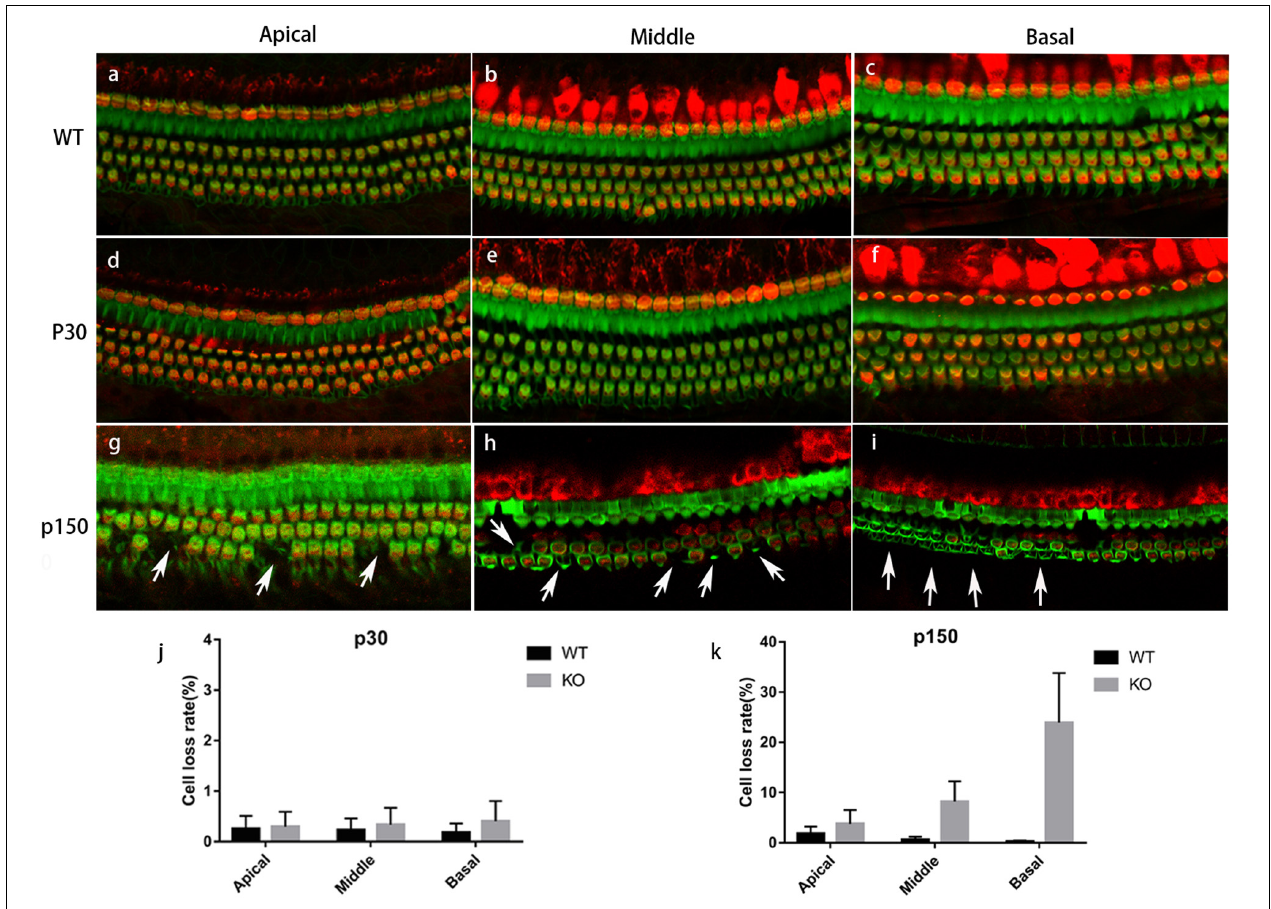
FIGURE 3 | Immunostaining of cochlea basilar membrane. Red: Myo7a, marking the cell bodies; Green: phalloidin, marking the stereocilia. (a-c) Basilar membranes from a p150 WT mouse. (d-f) Basilar membranes from a P30 Smpx KO mouse. No cell loss was detected, but some OHC bundles were out of shape. (g-i) Basilar membrane from p150 Smpx KO mice. Cells loss was sporadically detected at the apical and middle turn, and a large number of cells loss were detected at the basal turn. Scale bar: 20 µ m. (j,k) OHC loss rate of mice at p30 and p150. This data indicated a progressive OHC loss consisting with the images